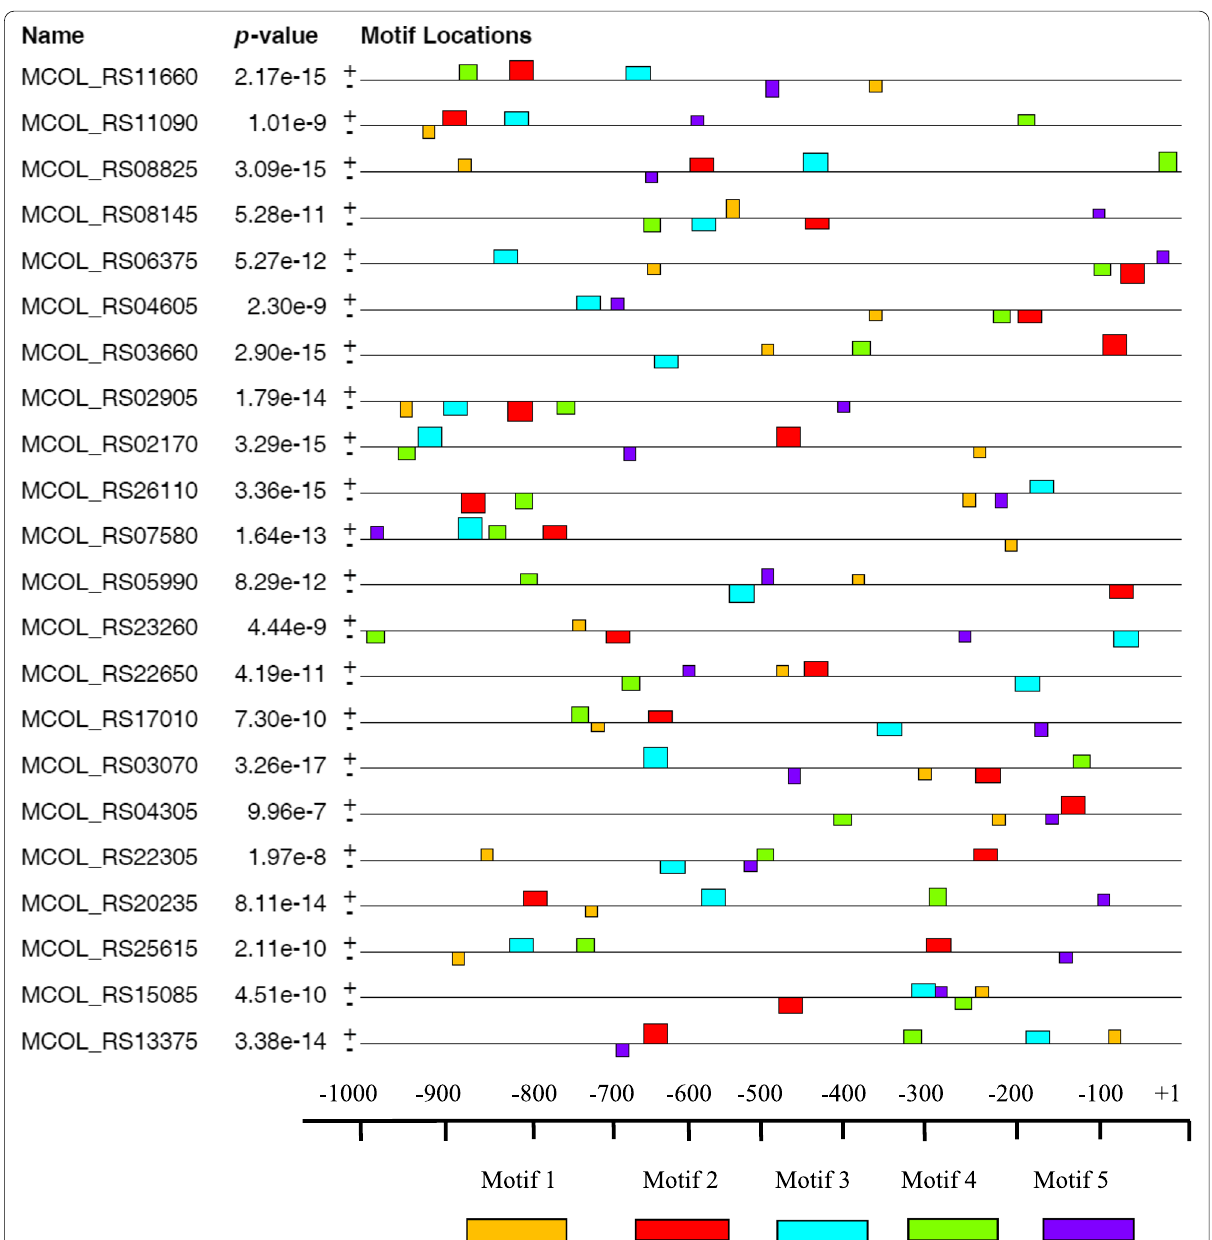
1 (beginning of TSSs) to the +